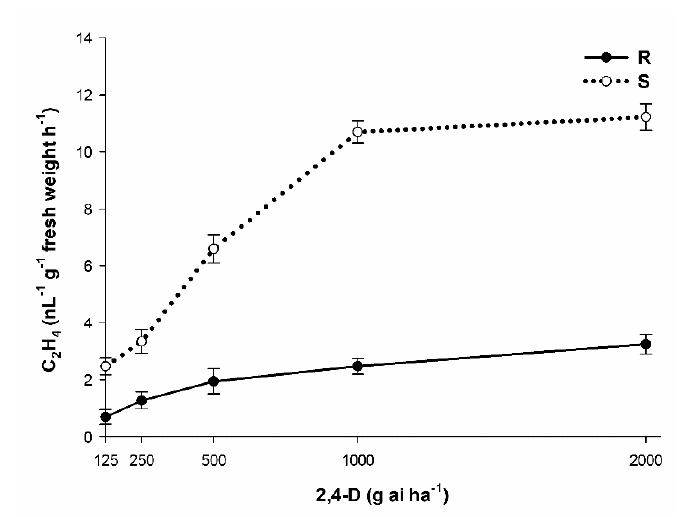
Figure 1. Ethylene accumulatation induced by 2,4-D in R and S P. hysterophorus populations. Vertical bars indicate ± standard errors of the mean ( n = 5).